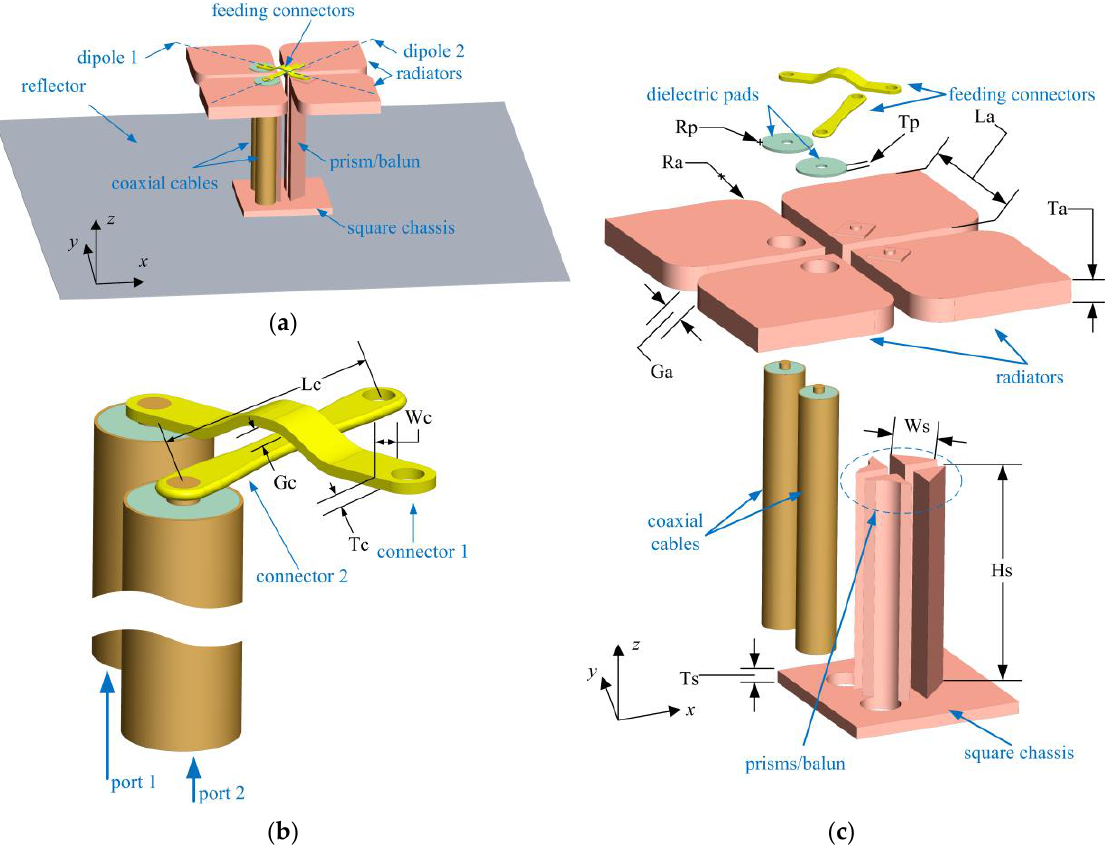
Figure 1. Proposed antenna configuration: ( a ) overview of the antenna, ( b ) detailed view of feeding structure, and ( c ) assembly view of the antenna structure without reflector.